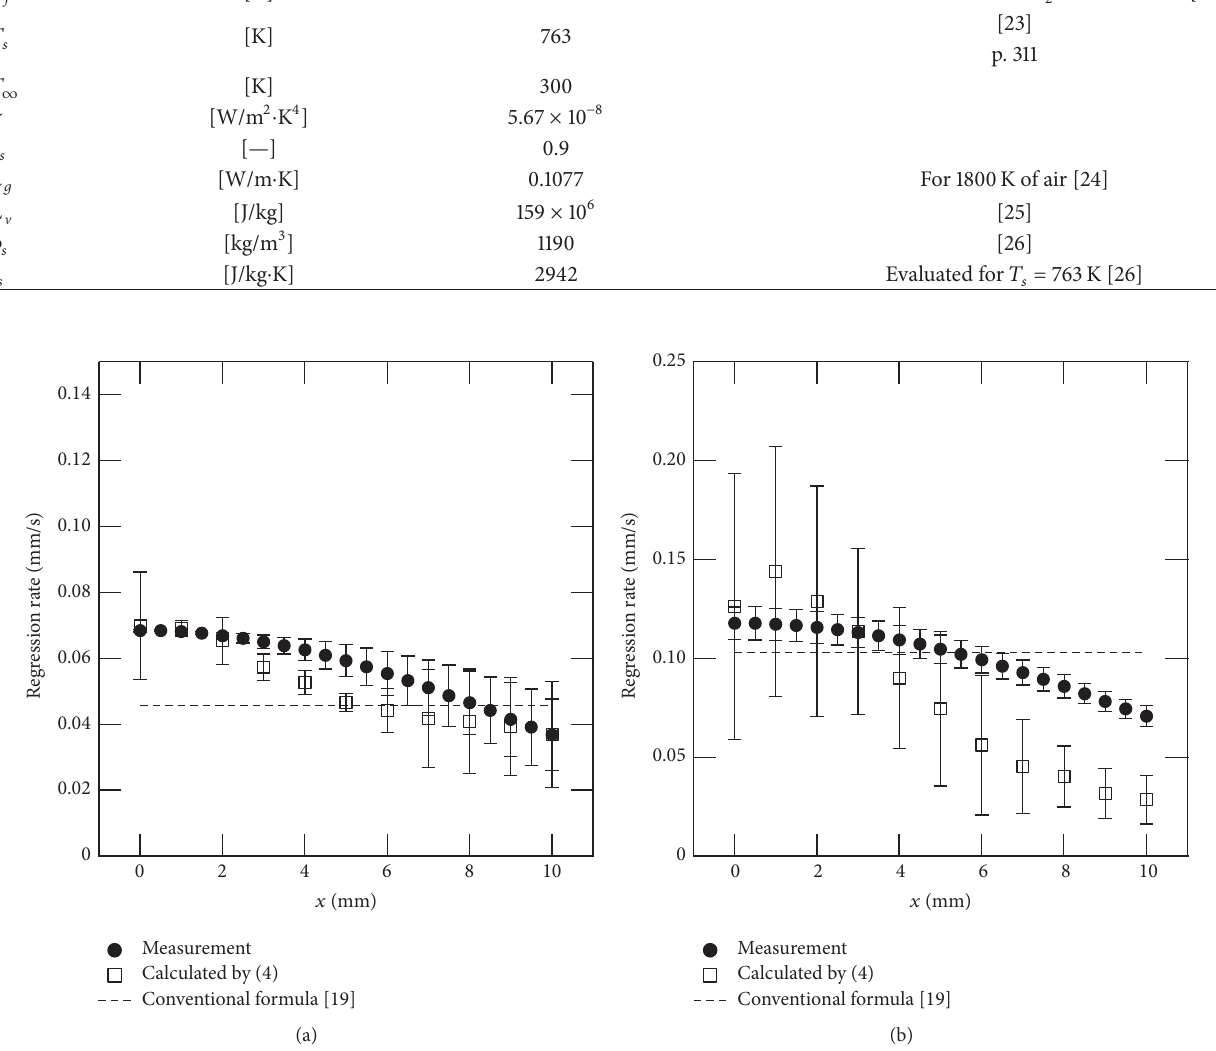
Figure 8: Comparison of local regression rates for (a) V = 1.9 m/s, offset value of 𝛿 = 1.7 mm, and (b) 5.6 m/s, offset value of 𝛿 = 0.15 mm.